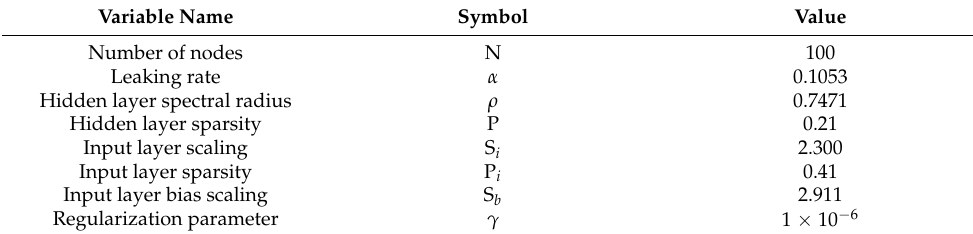
Table 2. Echo state network